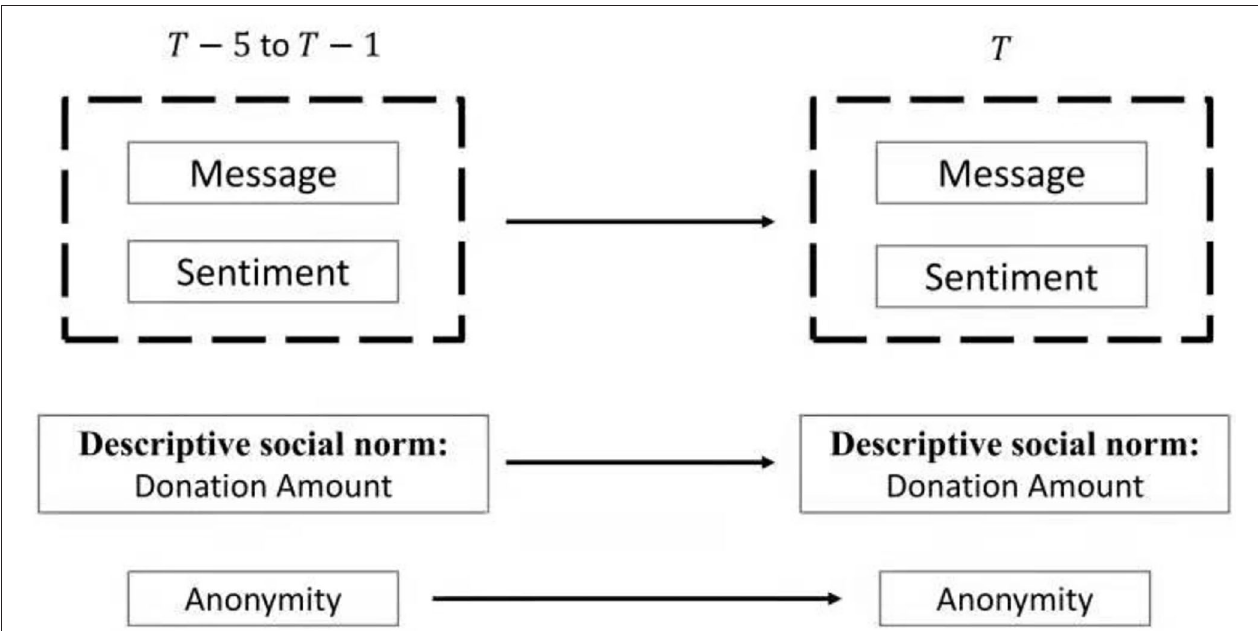
FIGURE 2 | Effect of norms on donations and positive sentiment.